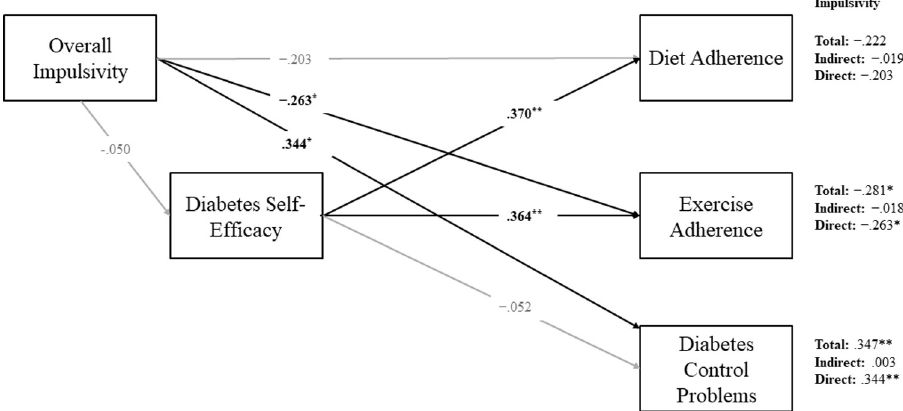
Fig 1. Path model estimating direct and indirect effects of impulsivity on self-care outcomes among individuals diagnosed with prediabetes, controlling for BMI. Completely standardized maximum likelihood parameter estimates shown. Unstandardized slopes of the indirect effects along with the bias-corrected 95% bootstrapped confidence intervals are provided in text. � p < .05, �� p < .01.